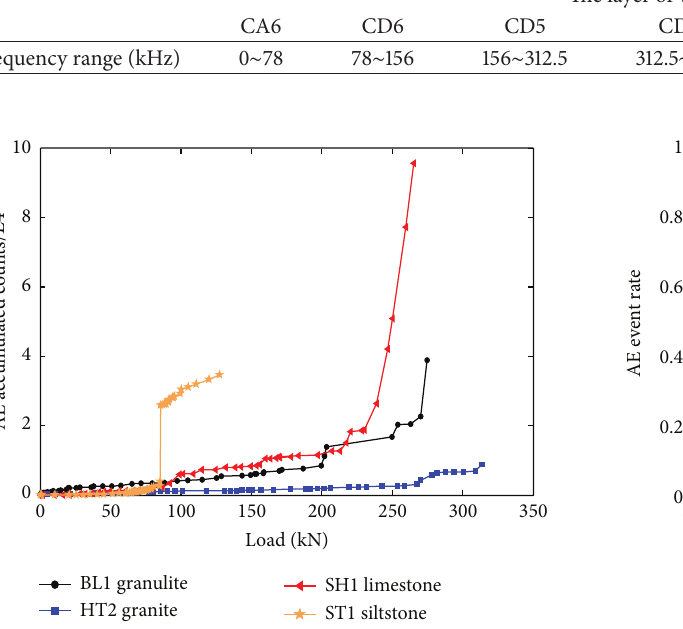
Figure 9: The curves of the AE rate and load for the four